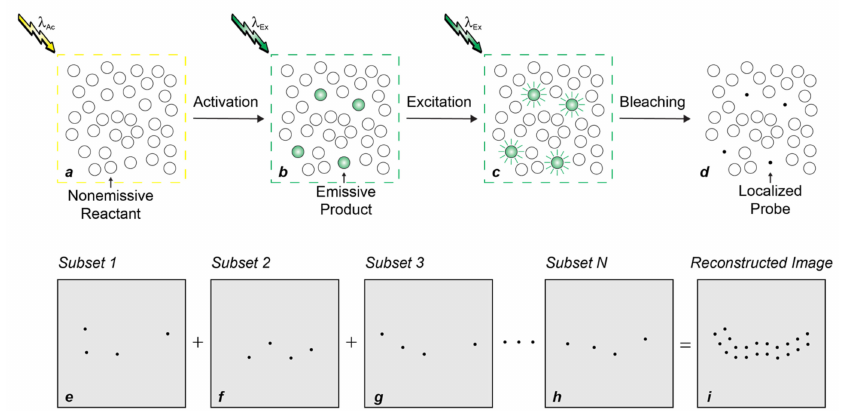
Figure 2. Sequence of steps ( a – i ) required for the reconstruction of an image with subdiffraction spatial resolution relying on fluorescence photoactivation and single-molecule localization.